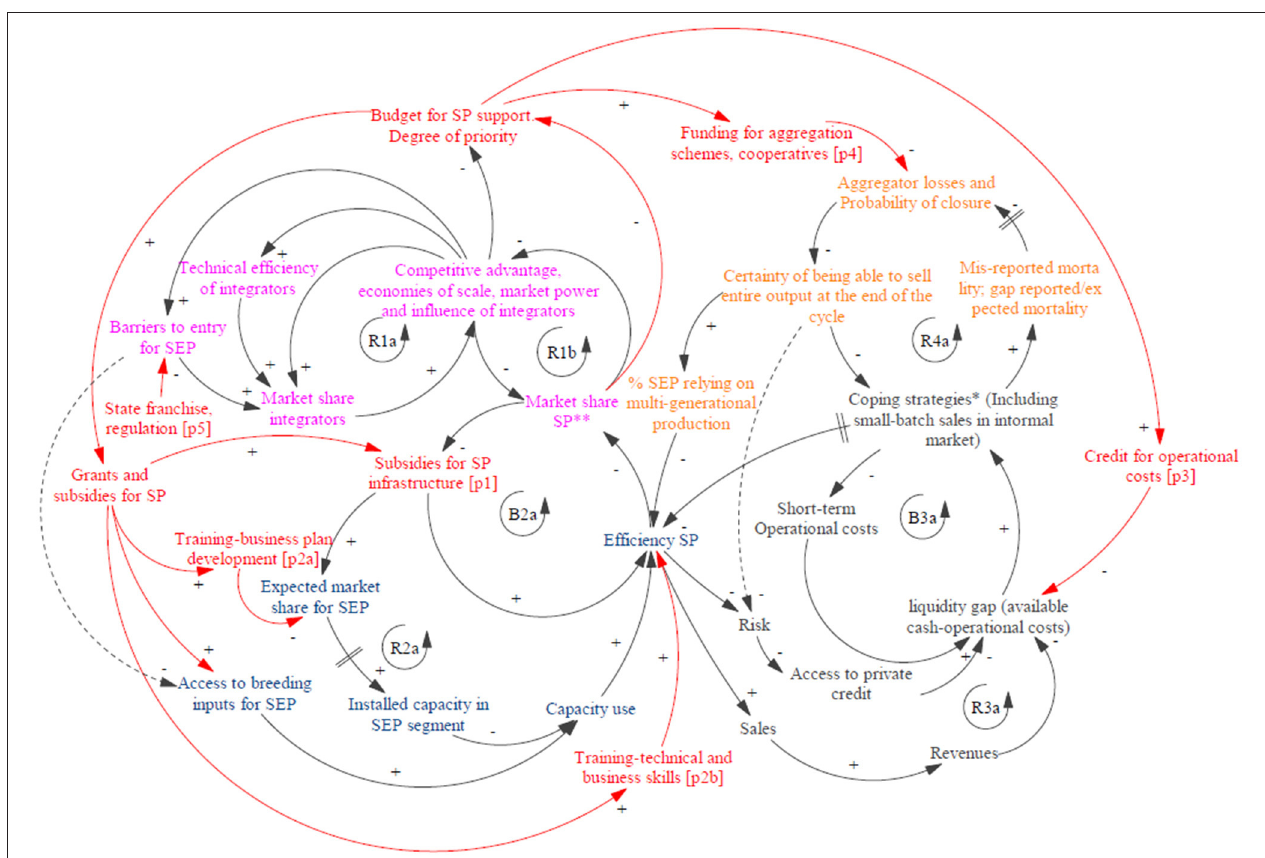
FIGURE 2 | Full causal loop diagram. Feedback loops are marked and labelled, R for reinforcing loops and B for Balancing loops. Arrows indicate causality. The signs + /- next to an arrow indicate the nature of the relationship between the two variables linked by the arrow. If an increase in the causal variable leads, all else equal, to an increase (decrease) in the caused variable, the sign will be positive (negative). SP stands for small producers. Variables corresponding to each Panel in Figure 1 are shown in different colours to improve readability. Pink: Reinforcing duality; blue: barriers to input access and overcapacity; black: short-term coping mechanisms and market access; yellow: failure of market aggregation mechanisms Policy entry points and flows of funds are shown in red. Some lines are dashed to improve readability.